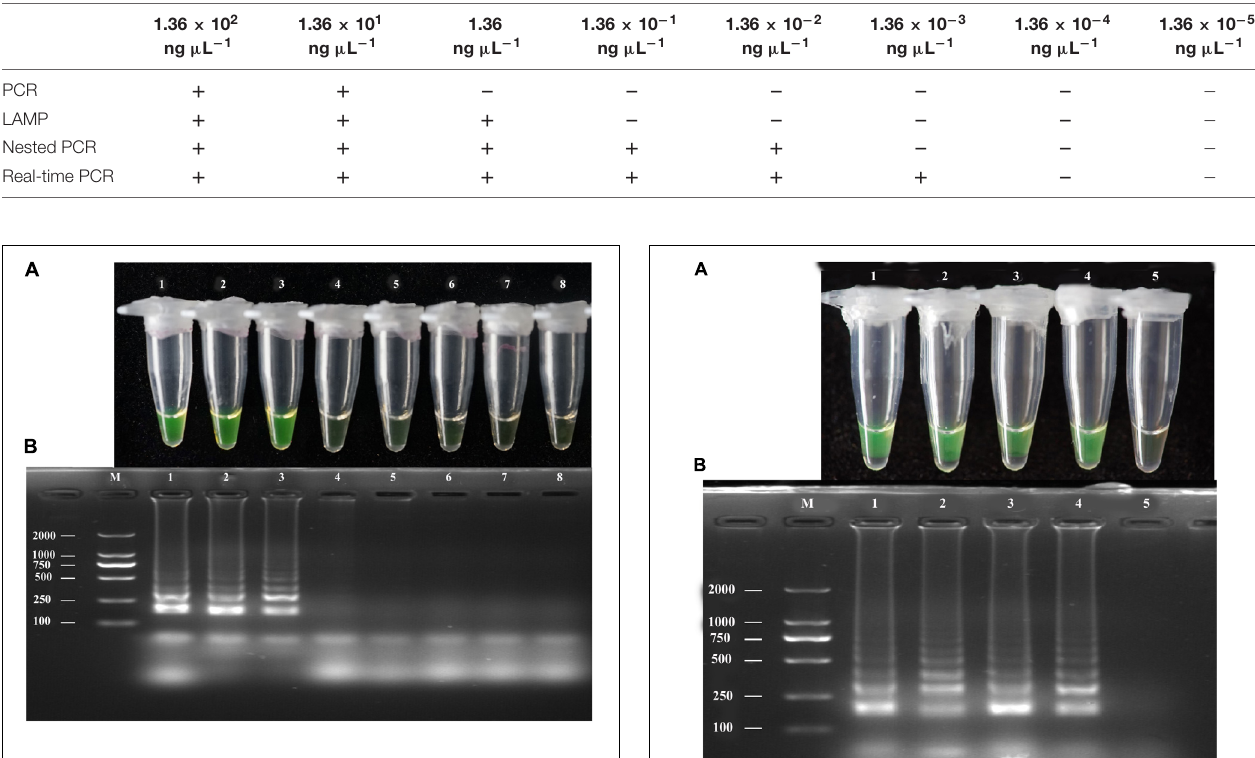
TABLE 3 | Comparison of the sensitivity of various PCR assays and LAMP conducted in this study.